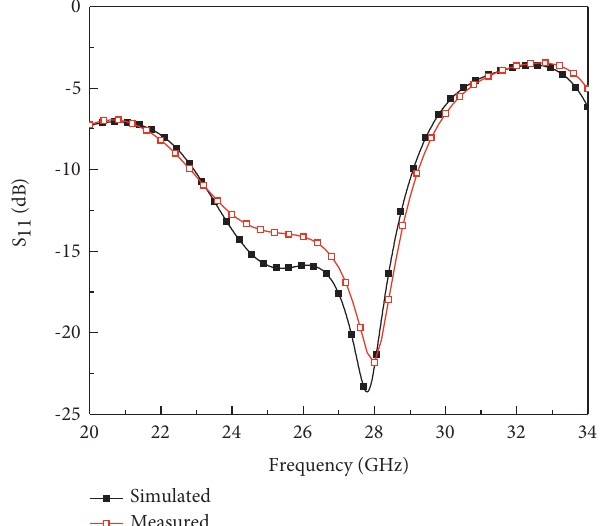
Figure 7: S characteristics of the proposed array. 11